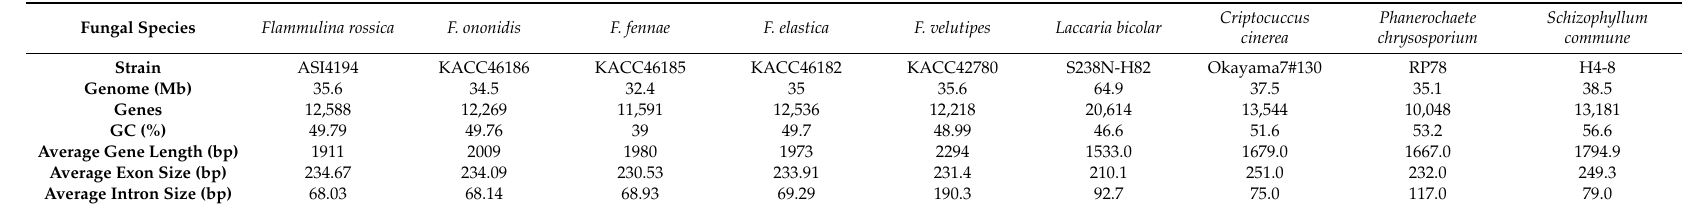
Table 2. Comparison of the Genome Characteristics of Flammulina rossica and other